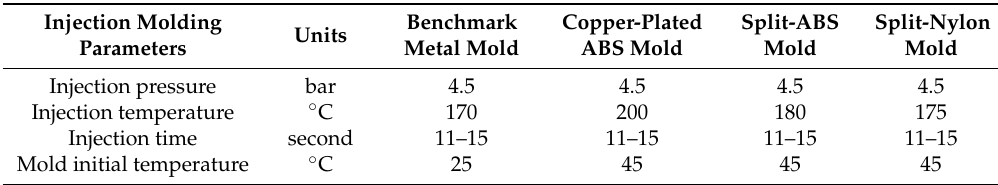
Table 1. Process parameters for MIM.